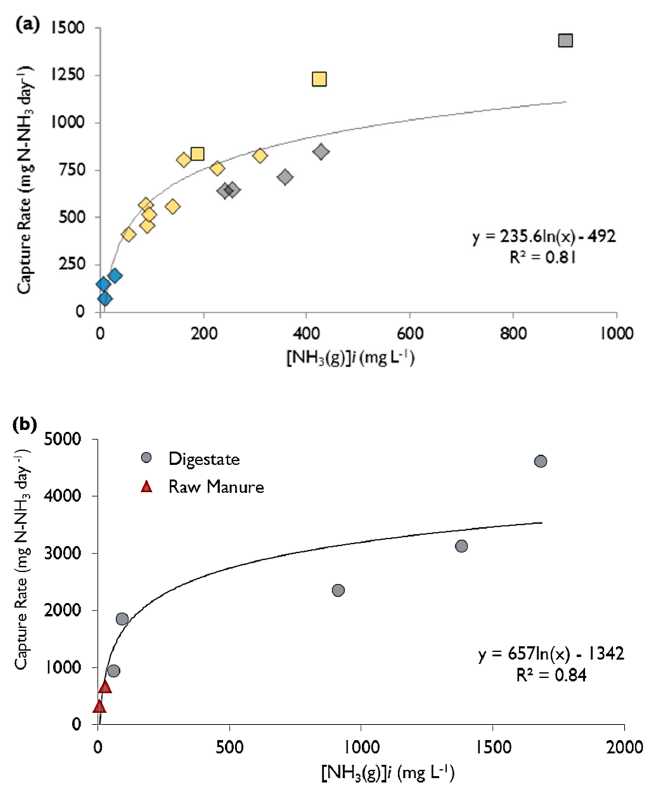
Figure 4. The capture rate of ammonia versus initial concentration of gaseous ammonia within the donor solution of ( a ) ammonium chloride, where experimental conditions varied the concentration of TAN, pH and temperature. Symbol type indicates temperature range ( ♦ : 22 to 25°C, □ : ≥ 30°C ) and symbol colour indicates pH range (blue: pH 7.0 to 7.5; yellow: pH >7.5 to 8.3; gray: pH >8.3); ( b ) digestate ( ● ) or raw manure ( ). For the experimental parameters corresponding to each data-point in (b), refer to Table 1.